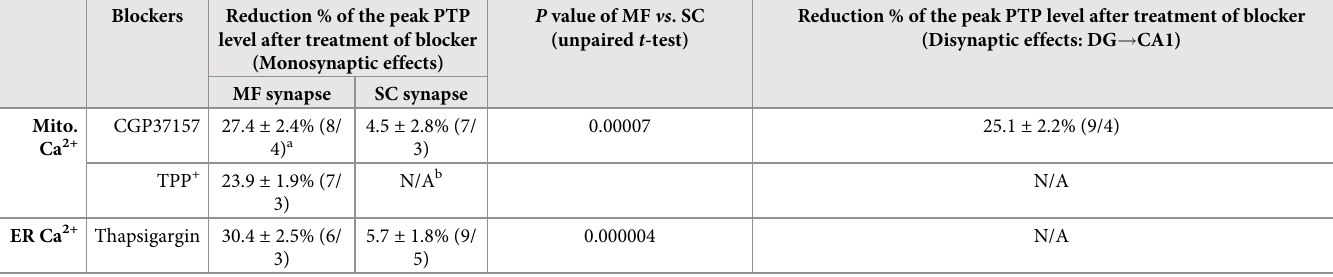
a The values in parentheses indicate the number of hippocampal slices (left) and the number of mice (right) used in each experiment. b N/A: not applicable.